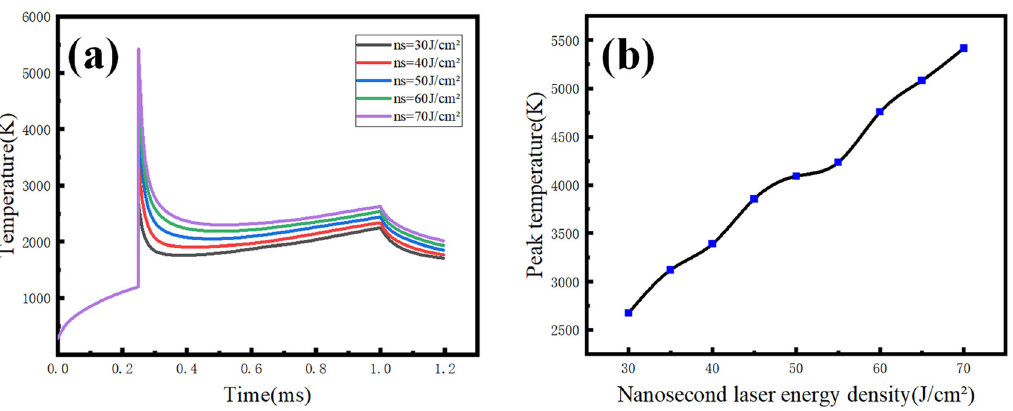
Figure 4. Variation in fused quartz surface temperature under different nanosecond laser energy conditions: ( a ) the relationship of the surface temperature of fused quartz with time; ( b ) the rela- tionship between peak temperature and nanosecond laser energy density.